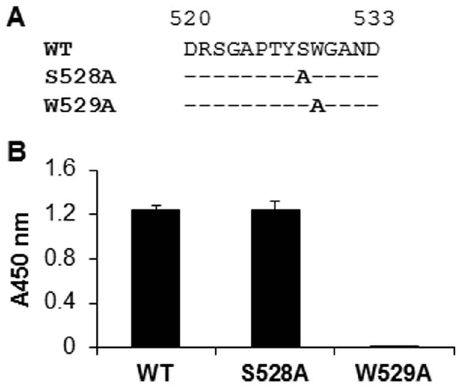
Figure 4. Recognition of a linear peptide from HCV E2 by 1H8. (A) Biotin-conjugated peptides containing amino acids from 520 to 533 of the E2 protein were chemically synthesized to represent the linear epitope of 1H8. Specific substitutions at positions 528 and 529 were introduced (in bold letters), one at the time. A hyphen represents an amino acid that is identical to that of the H77 strain sequence. (B) Detection of the binding of 1H8 to the epitope peptides in an ELISA. A biotin-linked peptide (200 ng) was coated onto a well of 96-well plate which was pre-coated with streptavidin. 1H8, at a 1:4000 dilution, was used as the primary antibody. HRP-linked anti-mouse antibody was used as the secondary antibody. The data were obtained from at least three independent experiments. The x-axis indicates the peptide used in the ELISA. The y-axis indicates the resulting absorbance at 450 nm, representing the specific binding of 1H8 to the